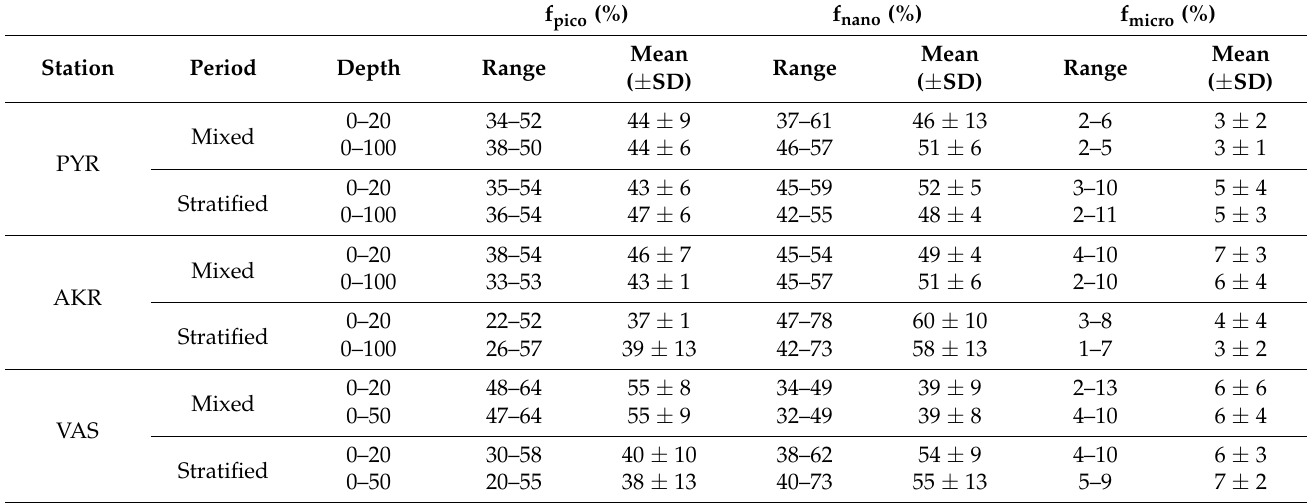
Table 3. Mean ( ± SD) estimated contribution of pico- (f pico ), nano- (f nano ) and micro-phytoplankton (f micro ) as derived from pigment analysis, integrated over the water column and the surface